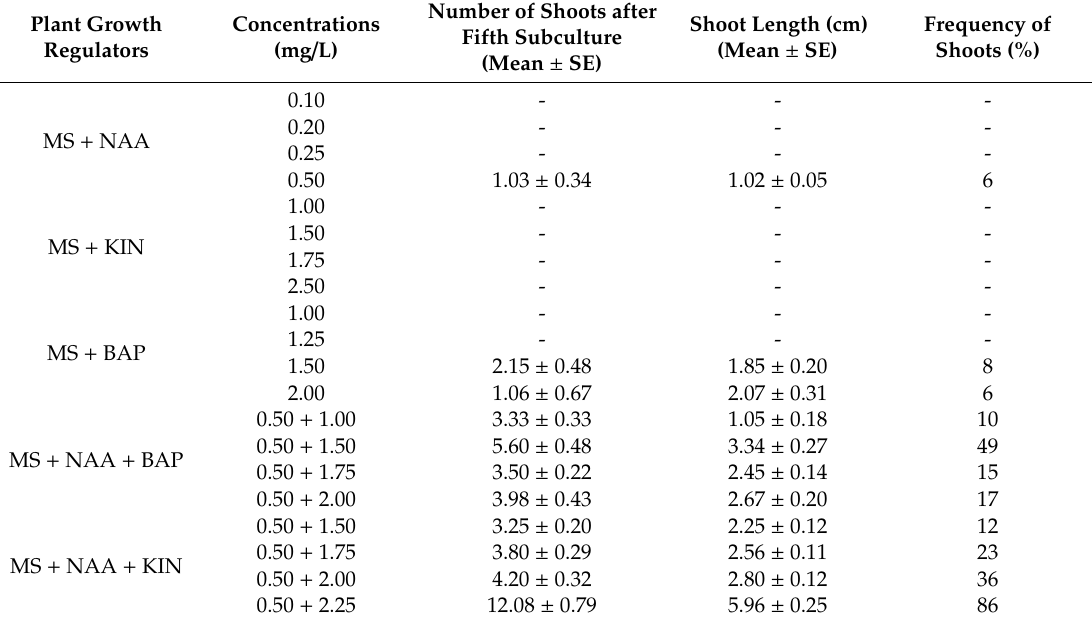
Table 2. Shoots regeneration from the calli of Viola serpens as influenced by plant growth regulators. Plant